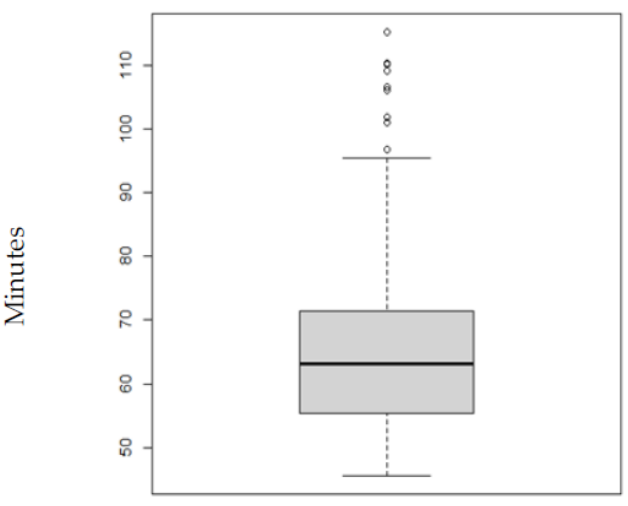
Figure 8. Box plot of the average travel time of every OD pair.